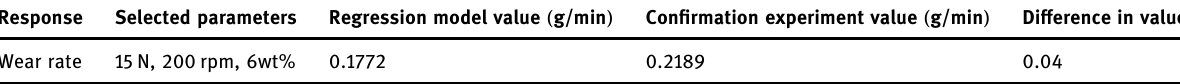
Table 7: Con fi rmation experiment results Response